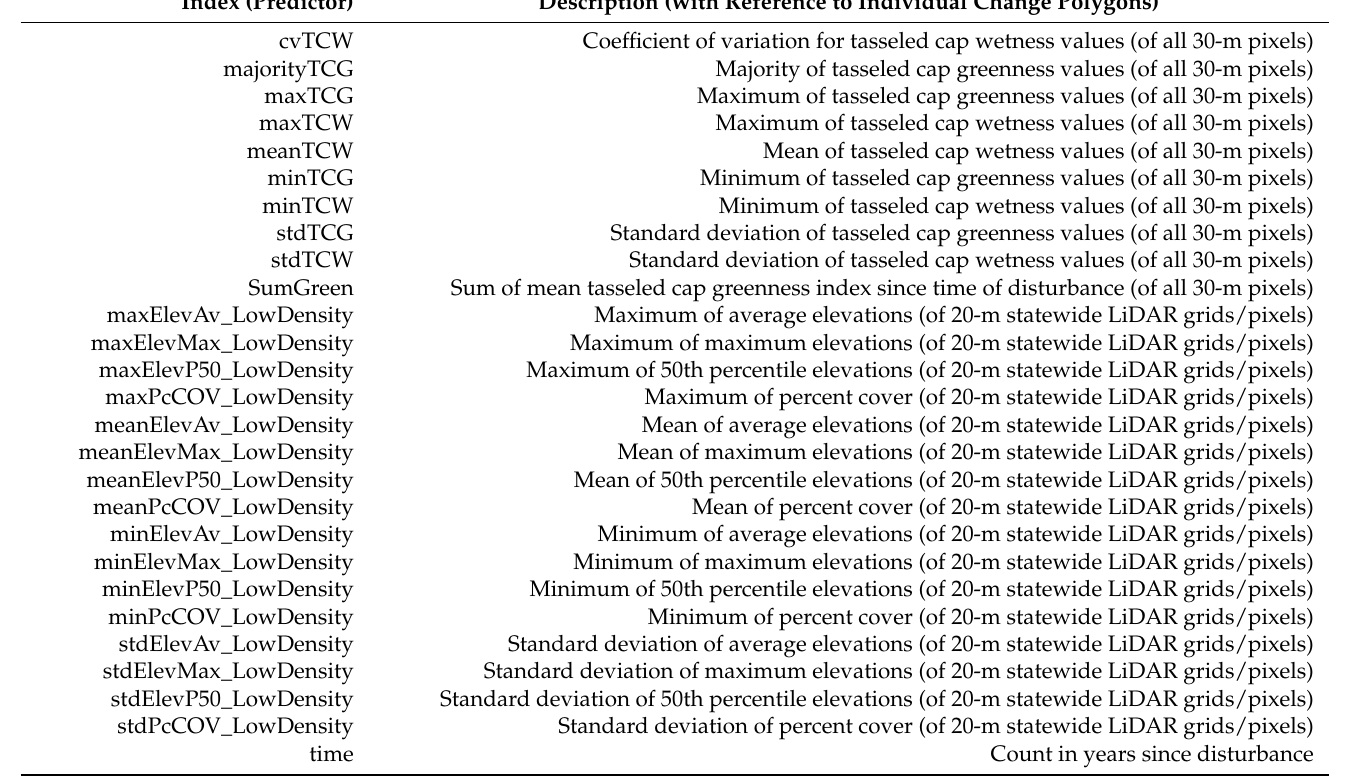
Table 2. Descriptions for spectral indices and LiDAR data used as predictors in models of above ground